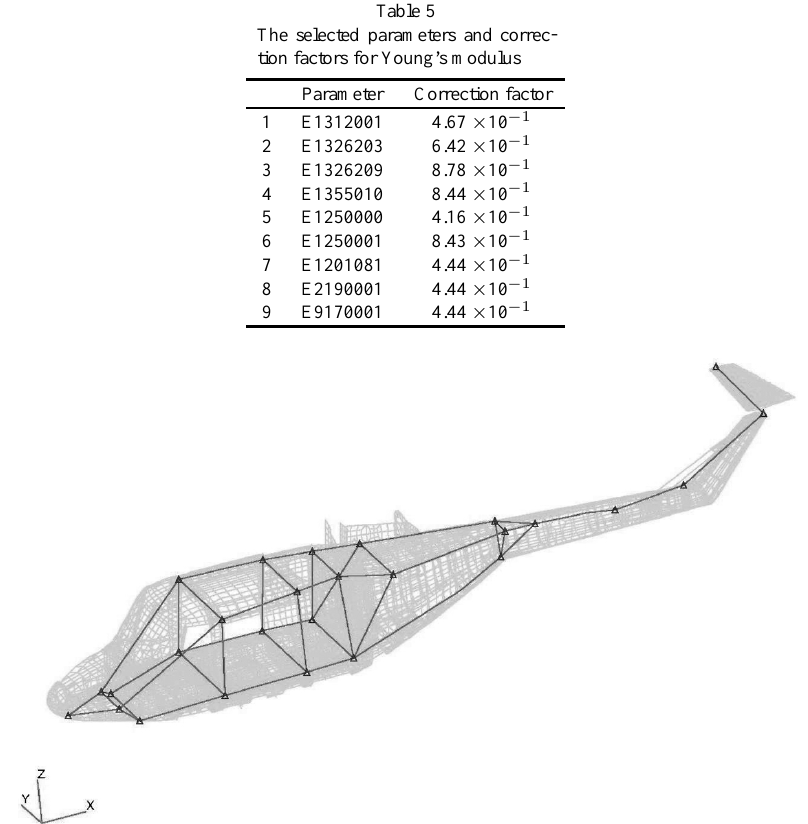
Fig. 7. Finite element model of the helicopter with test wire